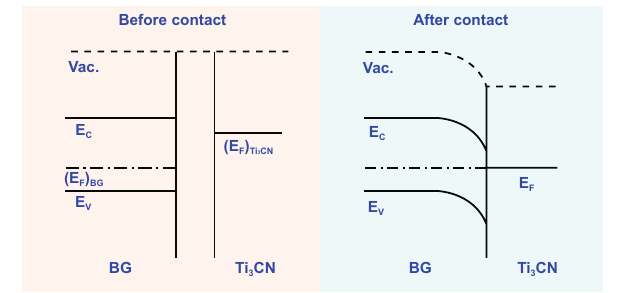
Fig. 7 Schematic of energy band structure at interface between